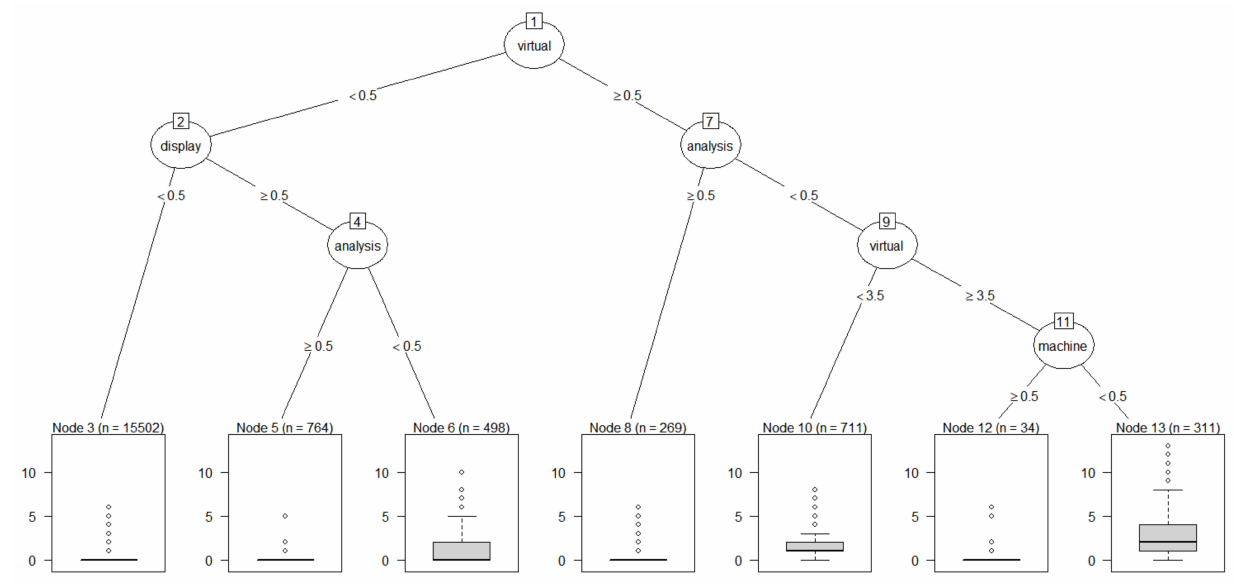
Figure 9. Regression tree plot of